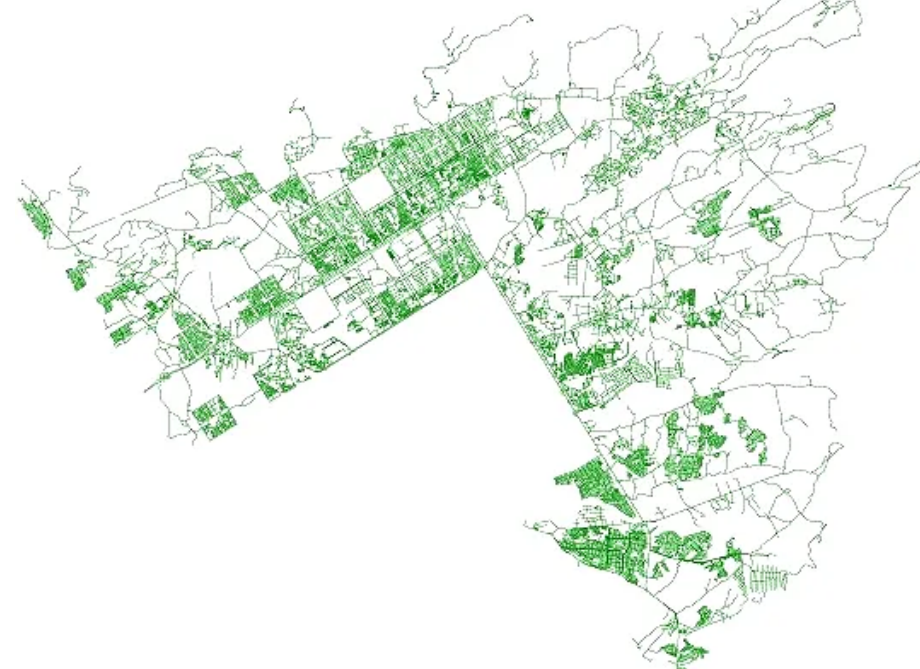
Figure 1. The location of the study area (Islamabad,